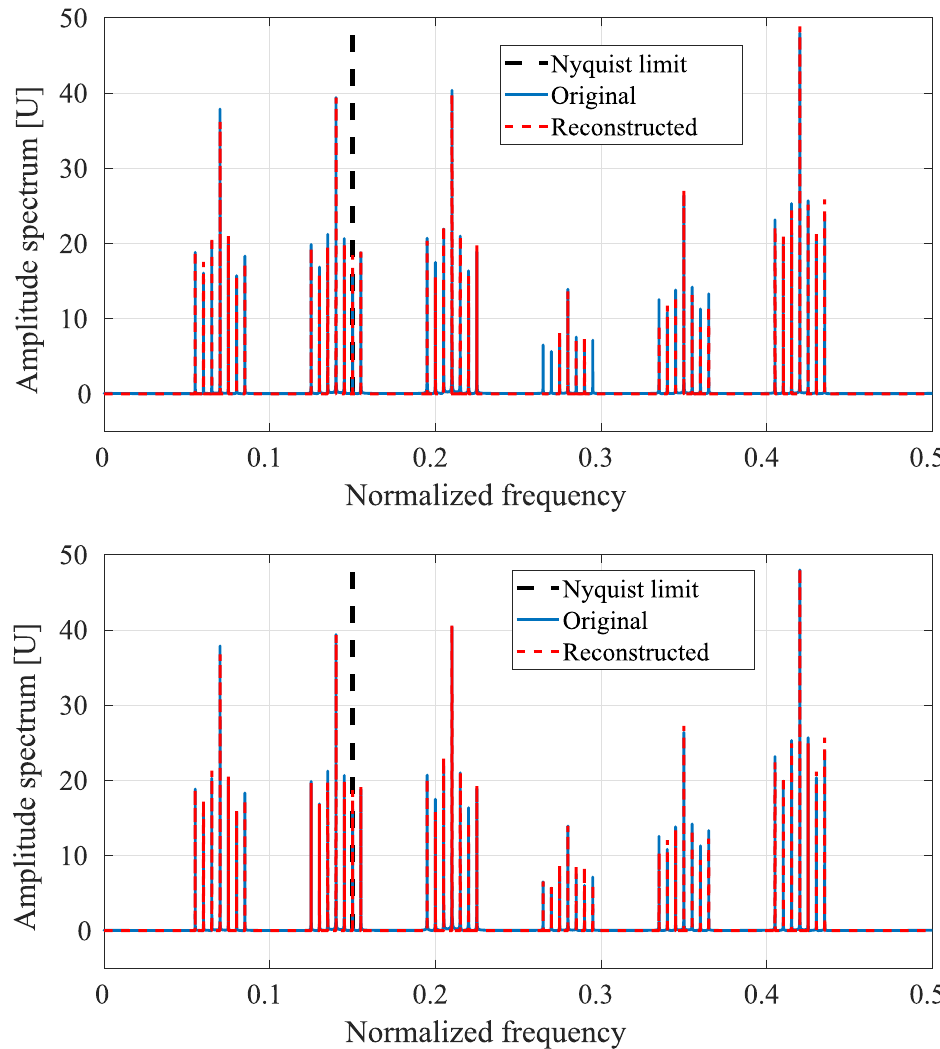
Figure 6. Reconstructed spectra using S&S-1A (top) and S&S-1B (bottom) for noise level 1.93 dB and compression rate